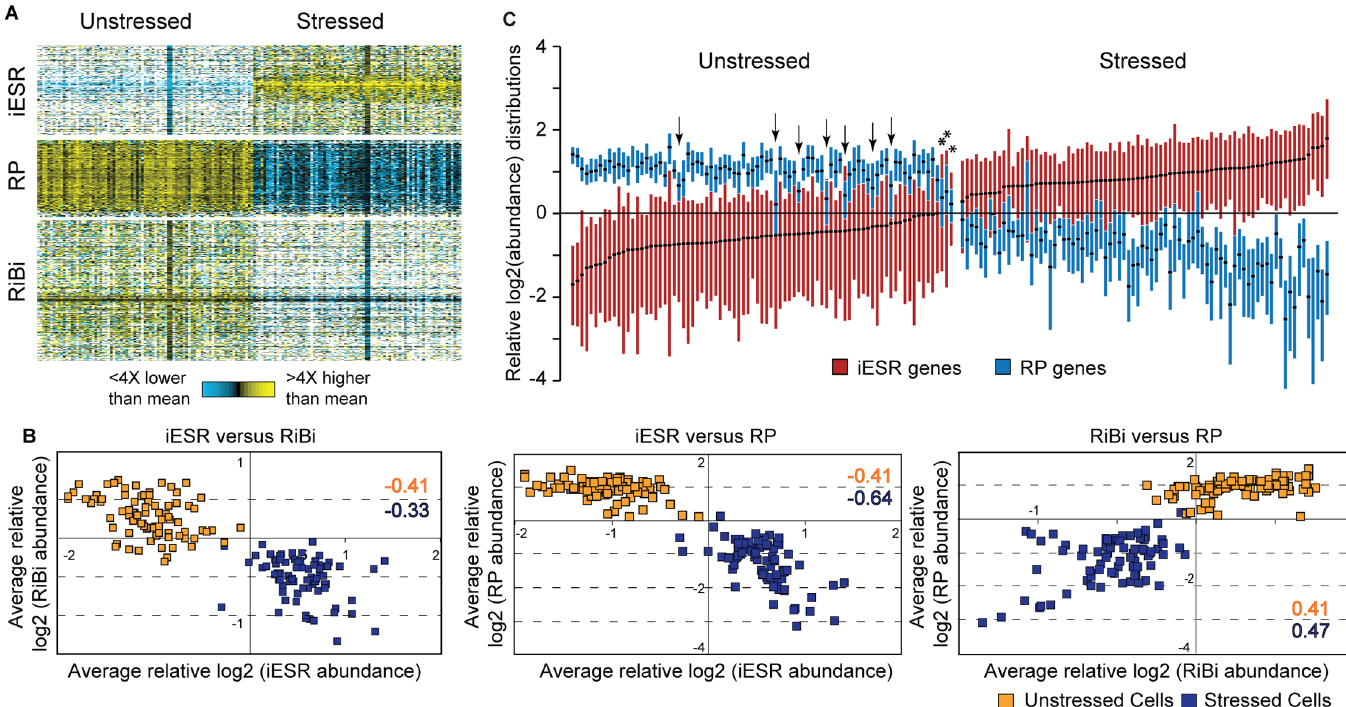
Fig 1. Quantitative variation in ESR activation across cells. (A) Mean-centered log 2 (read counts) for ESR genegroups before and after stress. Each row represents a transcript and each column is an individualcell, with expressionvalues accordingto the key; white indicates no detected transcript. (B) The averagemean-centered log 2 values for a given ESR gene group as measuredin one cell was plotted against the averagemean-centered log 2 values for a second ESR gene group as measuredin the same cell. Correlationsfor unstressed (orange) and stressed (purple) cells are indicatedon each plot. (C) Boxplots (without whiskers) of mean-centered log 2 (read counts) of RP and iESR transcripts in individualcells, sorted by iESR-group median. Arrows indicate unstressedcells with unusually low RP transcript abundances(FDR < 0.05, see Quantitative variationin ESR expression) and asterisks indicatethose cells that also had high medianiESR log 2 values. ESR, Environmental Stress Response;FDR, false discovery rate; iESR, induced-Environmental Stress Response;RiBi, ribosomebiogenesis;RP, ribosomal protein.